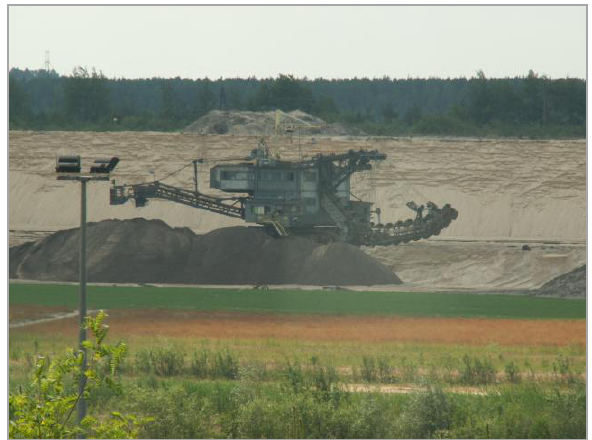
Fig. 4. Vegetation at the bottom of sandpit in Bukowno – near draining canal ( J. Pełka-Gościniak, June 2010